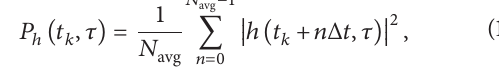
Figure 3. No transition took place from OLOS-to-NLOS. The NLOS does not usually occur on highways, and the data samples for NLOS data in urban measurements are too few to be plotted as a